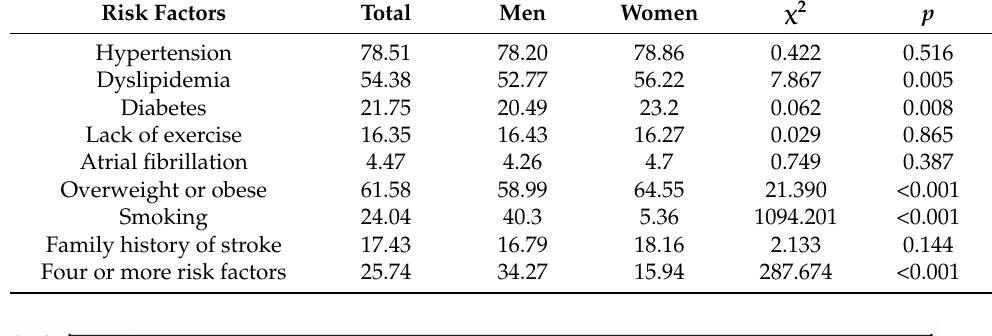
Table 2. Prevalence of risk factors of stroke patients in China (%).